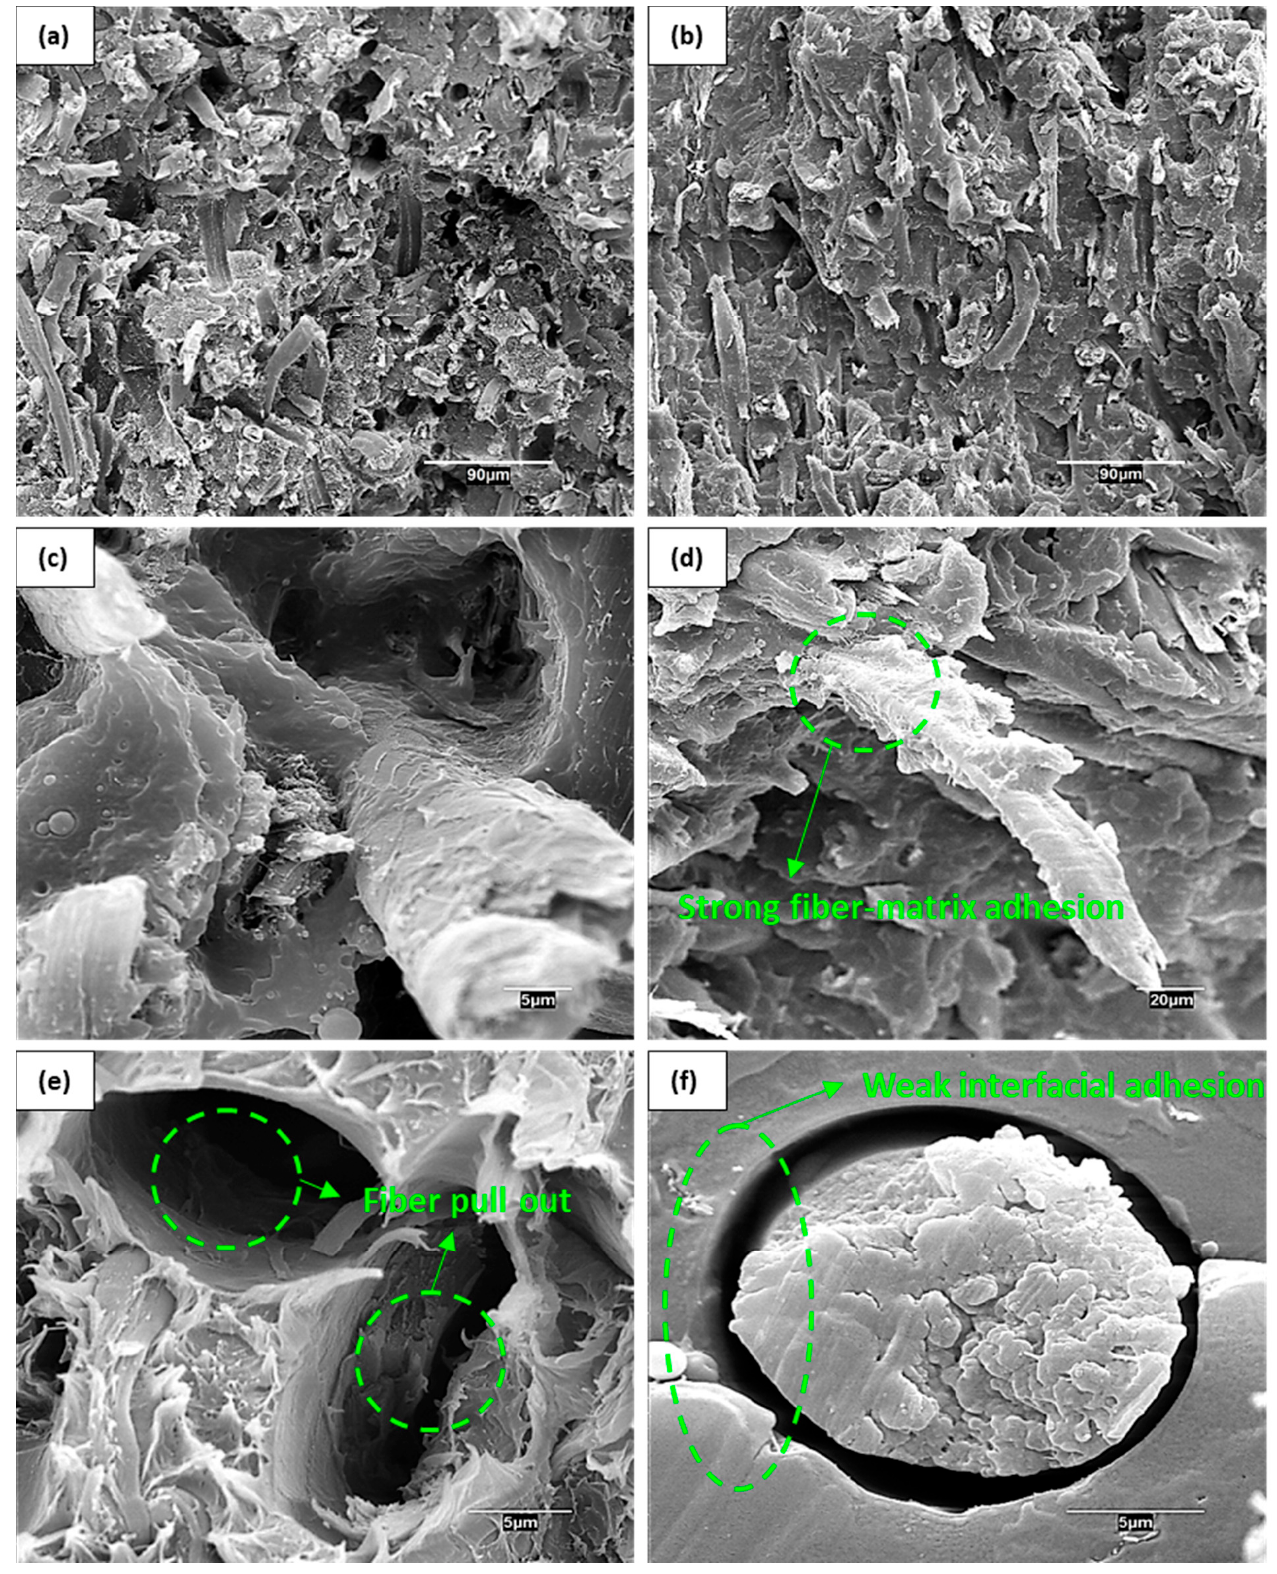
Figure 3. SEM micrographs at the cross-sectional area of the flexural specimens in composites containing 40 wt.% of cotton fibers. Observation of the composites with ( a ) and without ( b ) MAPP at low magnifications. Observation at higher magnification of composites with MAPP ( c , d ) and without MAPP ( e , f ).